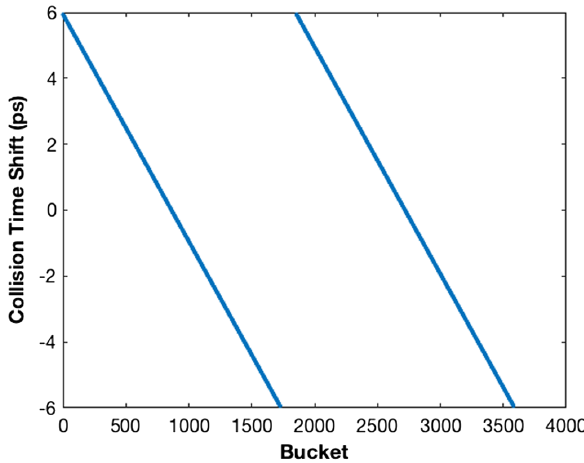
FIG. 19. Collision time shift due to reference phase